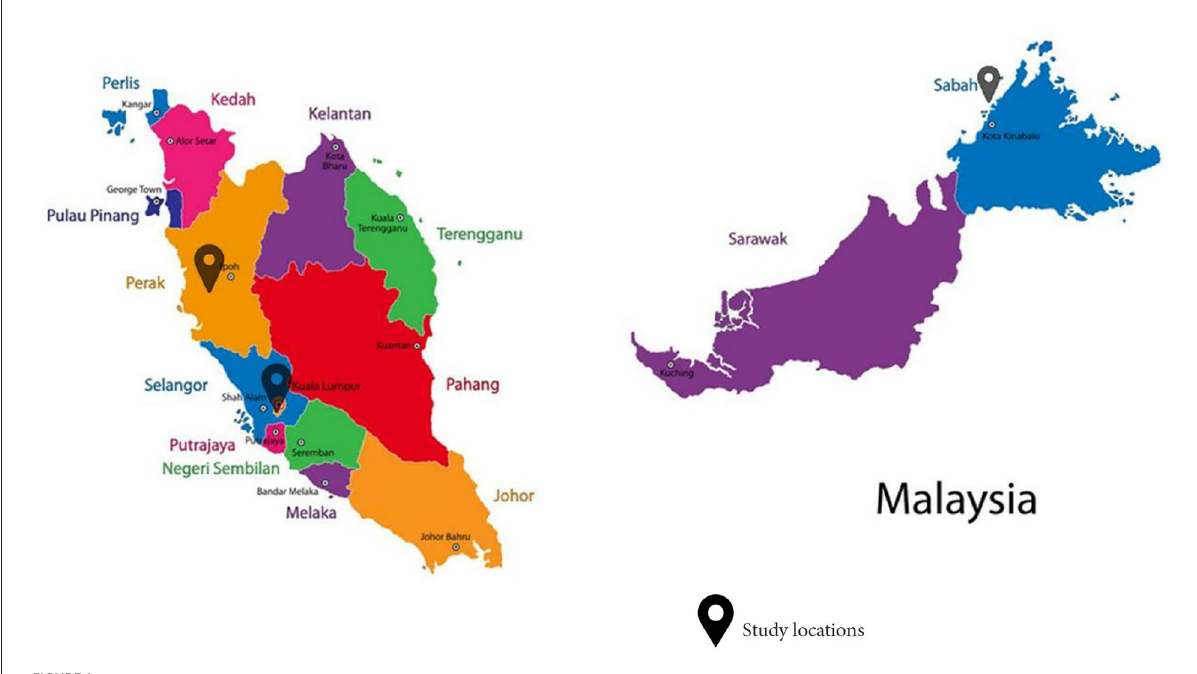
FIGURE1 Map of study